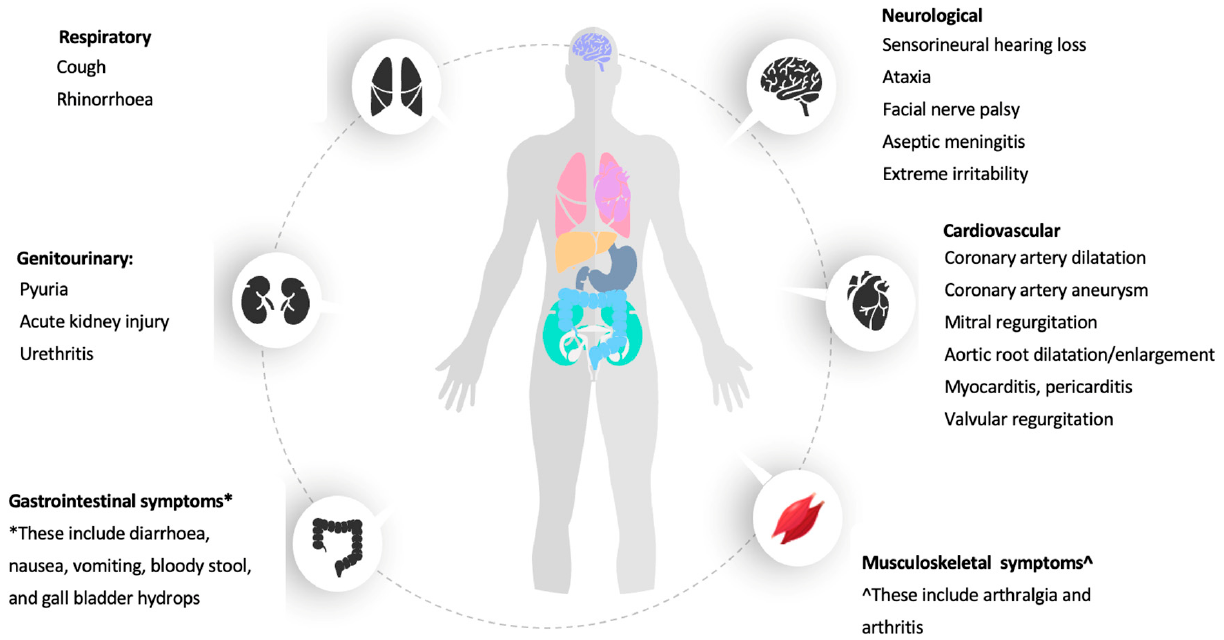
Figure 1. A summary of the clinical features of